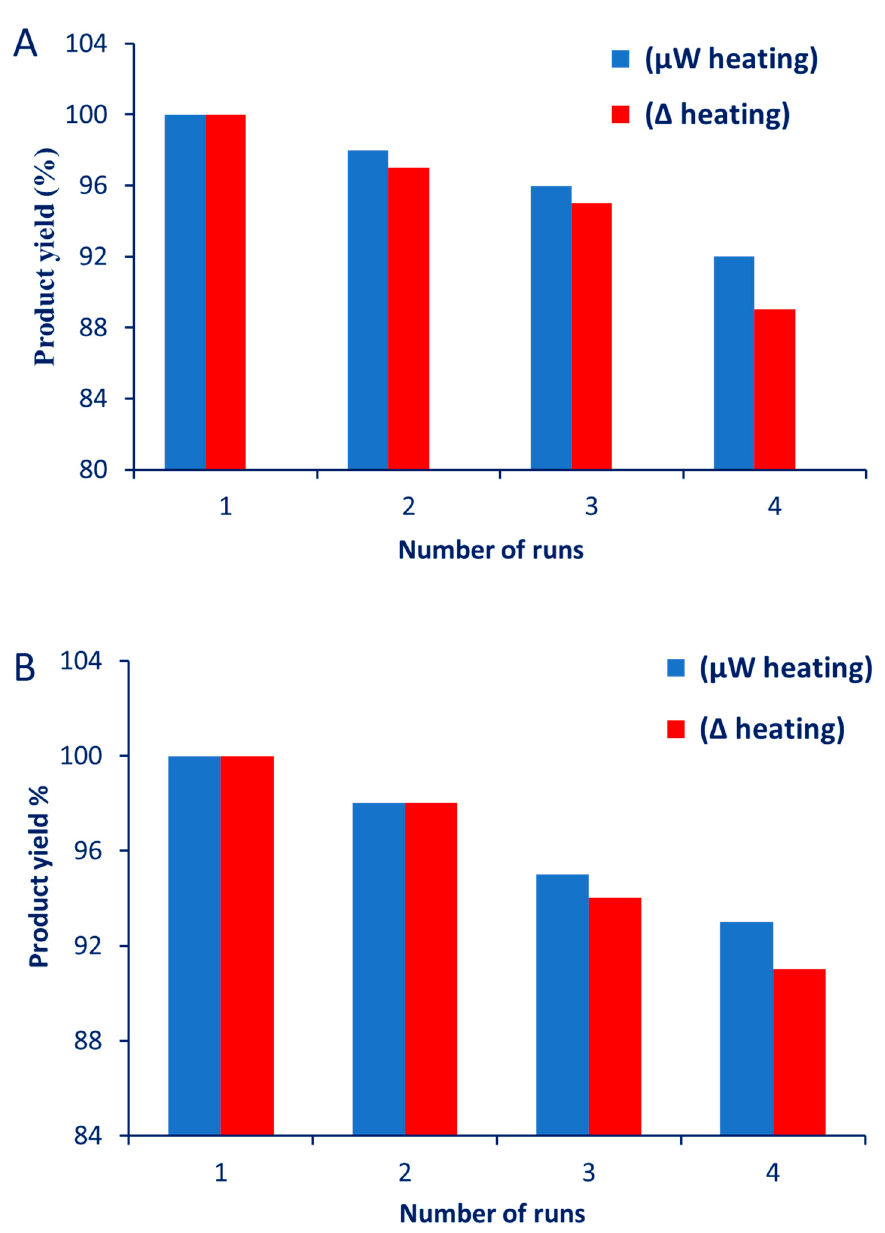
Figure 4. Reusability of Pd-SiO 2 in the reduction reaction of ( A ) 4-nitrobenzylalcohol and ( B ) 4-ni- trophenylhydrazine. ( B )